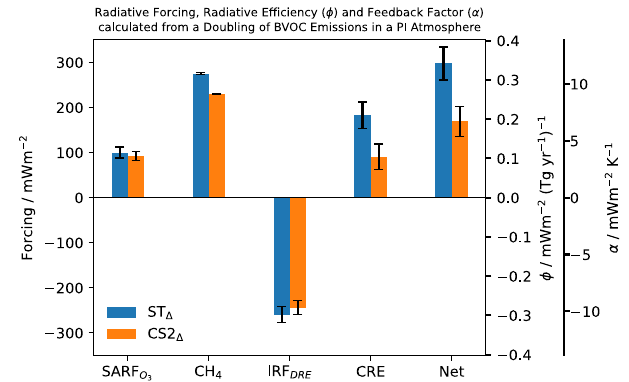
Fig.2|Radiativeforcing,radiativeef fi ciency( ϕ )andfeedbackfactor( α )froma doubling of BVOC emissions in a pre-industrial (PI) atmosphere. We show the individual forcing components from changes to O 3 (SARF O3 ), CH 4 , the aerosol direct radiative effect (IRF DRE ) and aerosol-cloud interactions (CRE) and their combined totals (Net) for Strat-Trop (ST Δ ) and CRI-Strat 2 (CS2 Δ ). The left axis shows the radiative forcing, the inner right axis the radiative ef fi ciency and the outer right axis the feedback factor. Error bars show the standard